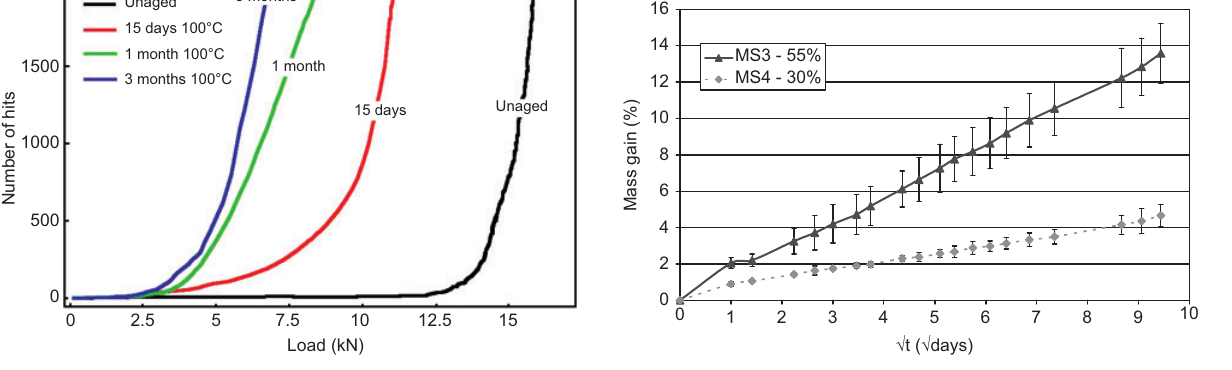
Figure 12 Gravimetry of syntactic foams (30 % and 55 % GM volume fractions) during ageing at 100 °